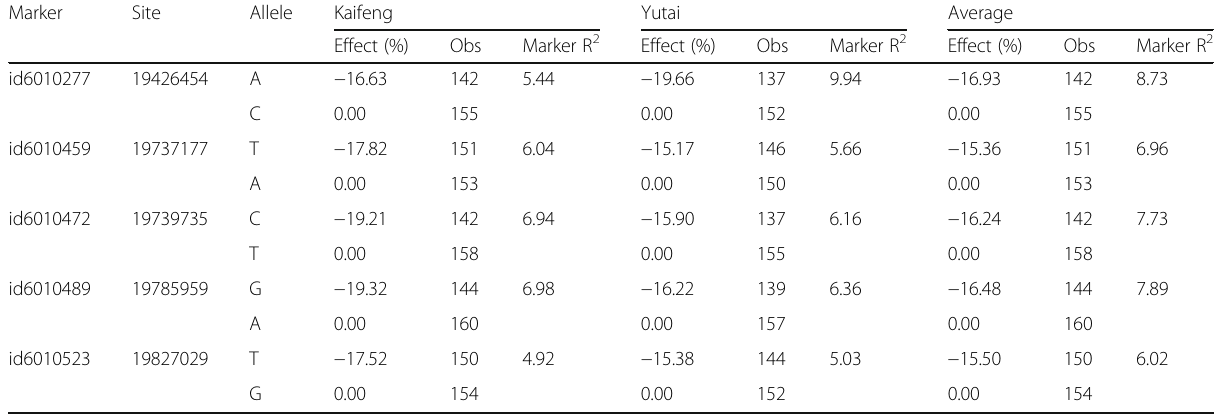
Table 3 Statistic information of the five significant association SNP markers in Kaifeng and Yutai locations Marker Site